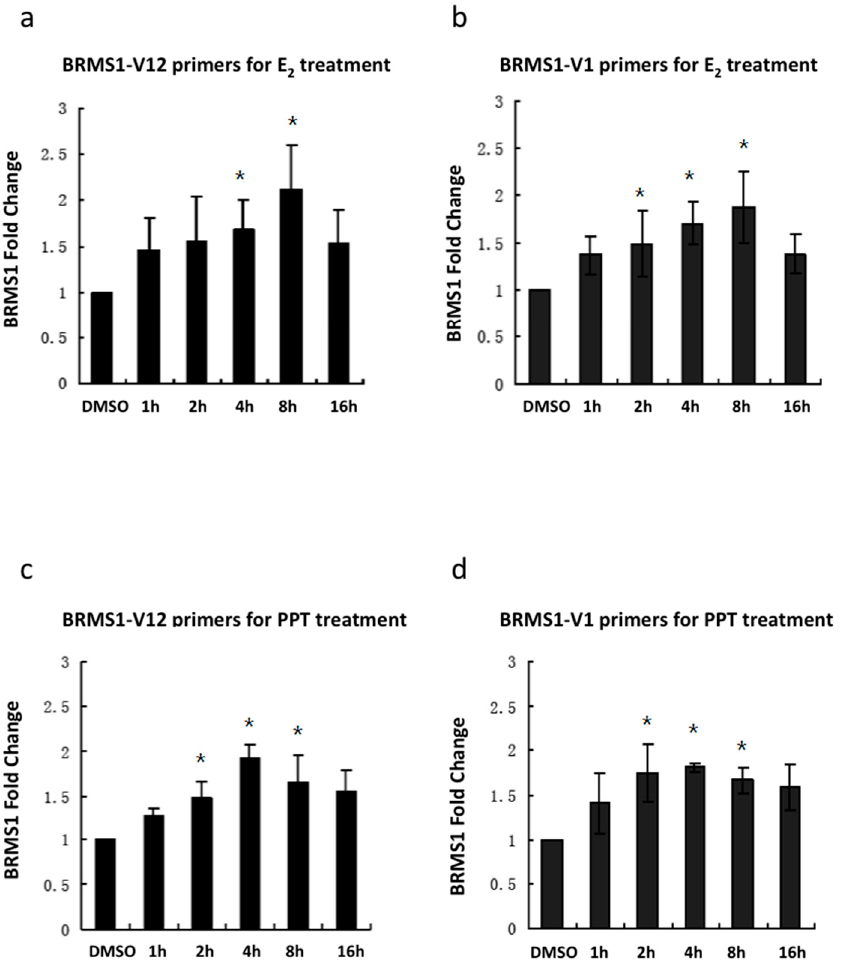
Figure 5. BRMS1 transcription was induced by treatment with E 2 or PPT. BRMS1 transcription for BRMS1 V12 primers ( a ) and BRMS1 V1 primers ( b ) after treatment with 10 nM E 2 demonstrated peak induction at 8 h; BRMS1 transcription for BRMS1 V12 primers ( c ) and BRMS1 V1 primers ( d ) after treatment with 10 nM PPT showed much earlier peak induction between 2 and 4 h. Values with error bars are the average of three independent experiments ± SD. * indicates statistical significance at the p < 0.05, compared to DMSO.